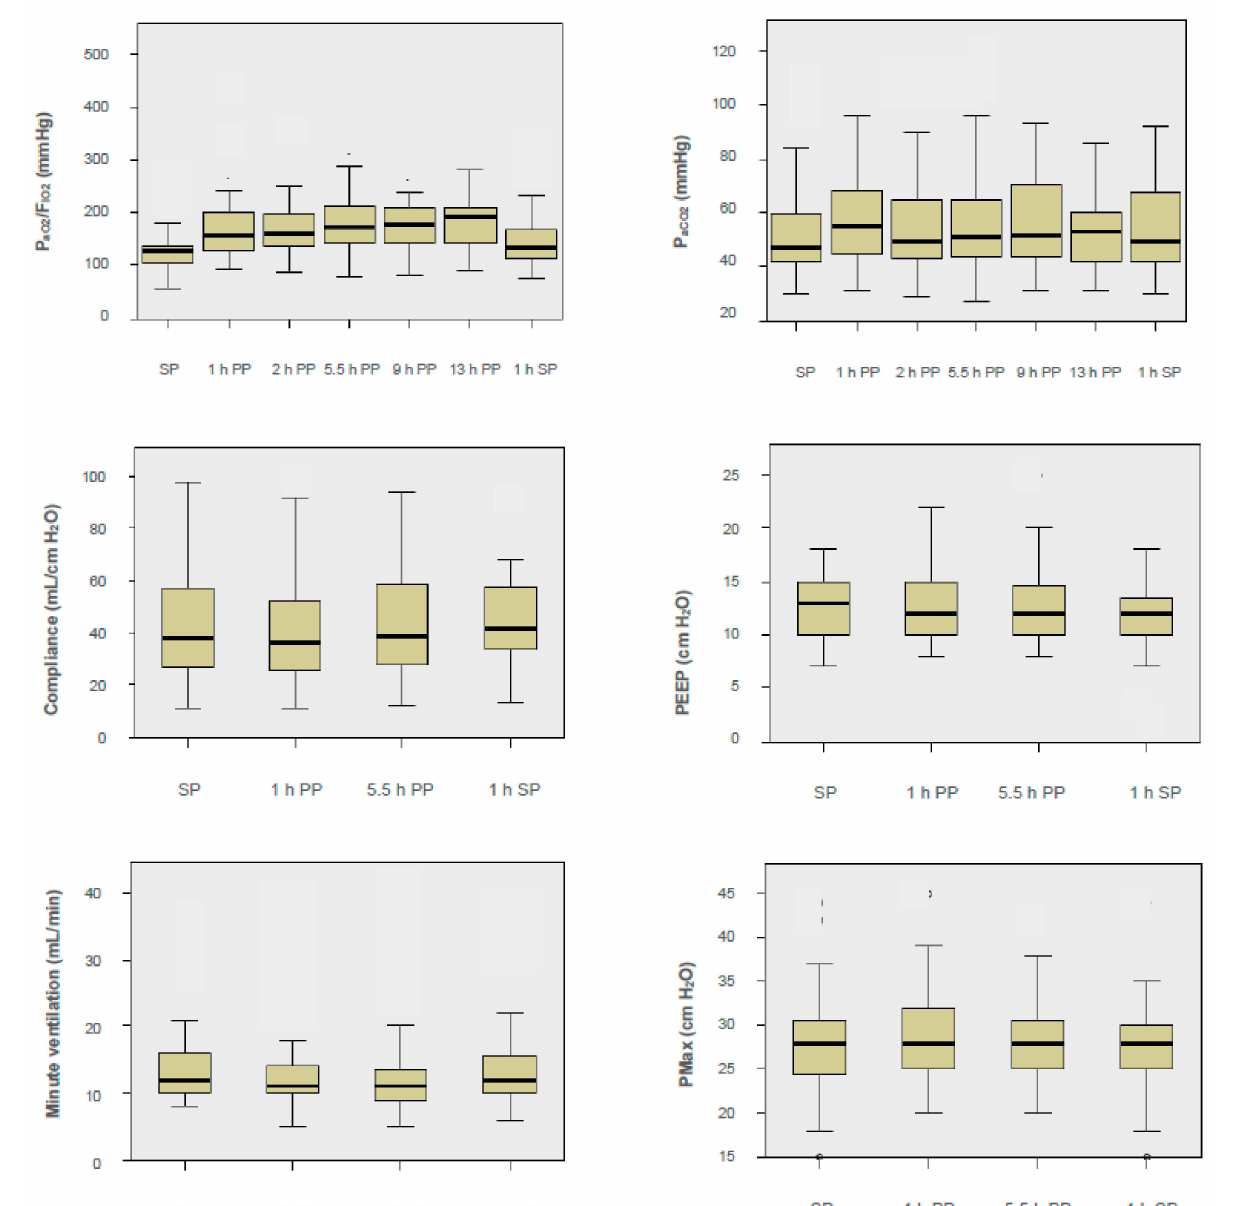
Figure 2. P aO2 /F IO2 , P aCO2 , lung compliance, minute ventilation, peak inspiratory pressure (P Max ), and positive end- expiratory pressure (PEEP) before and during the prone and supine